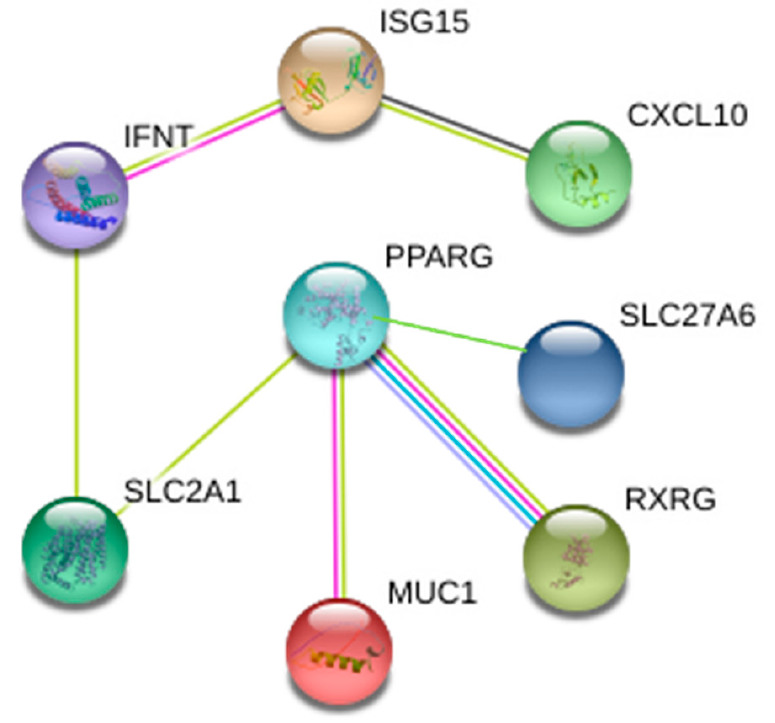
Figure 5. Simple interactive pathway of genes on gestational Day 16 of bovine pregnancy.